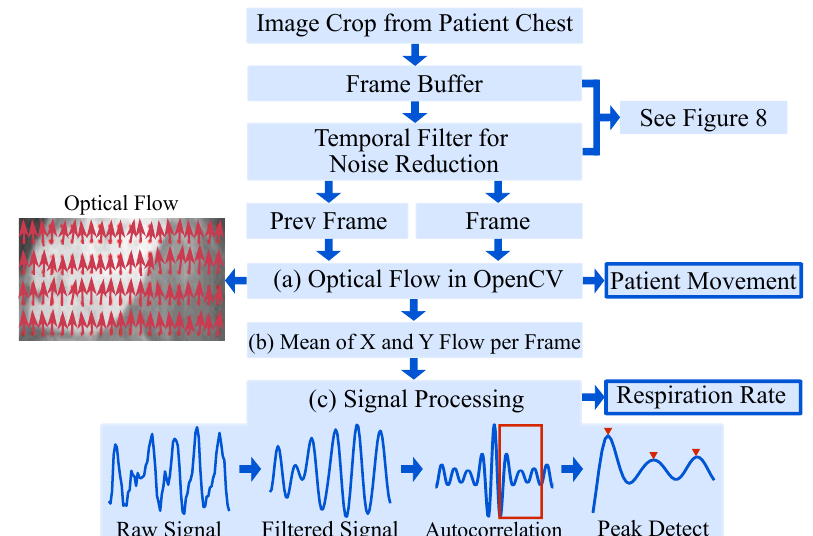
Figure 7. Overview of the algorithm for RR extraction.